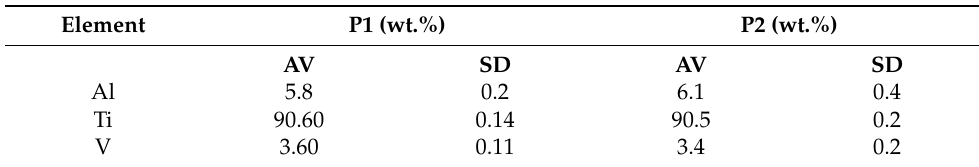
Table 4. Chemical composition (wt.%) of P1 and P2 powders obtained by EDS analysis. AV—average value, SD—standard deviation.